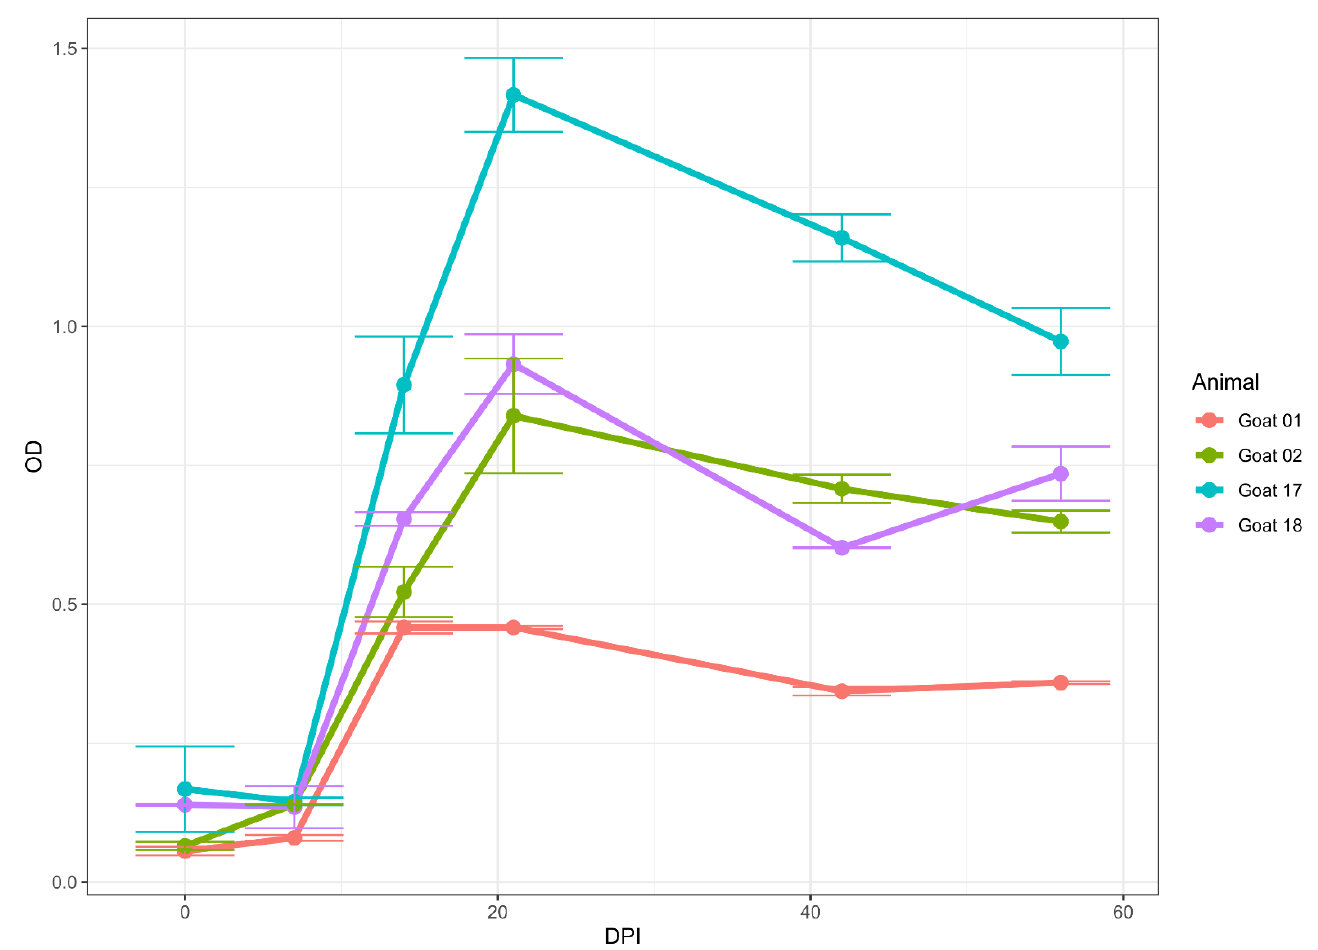
Figure 5. Immunoreactivity (seroconversion) of serum samples from goats experimentally infected with virulent GTPV Oman 84 isolates. Four goats were inoculated, and samples were collected at 7, 14, 21, 28, 35, 42, 49, and 56 DPI. Note that a raise in immunoreactivity was observed between 7 and 14 DPI for goats. The data represent the average of two runs in duplicate ± standard deviation.